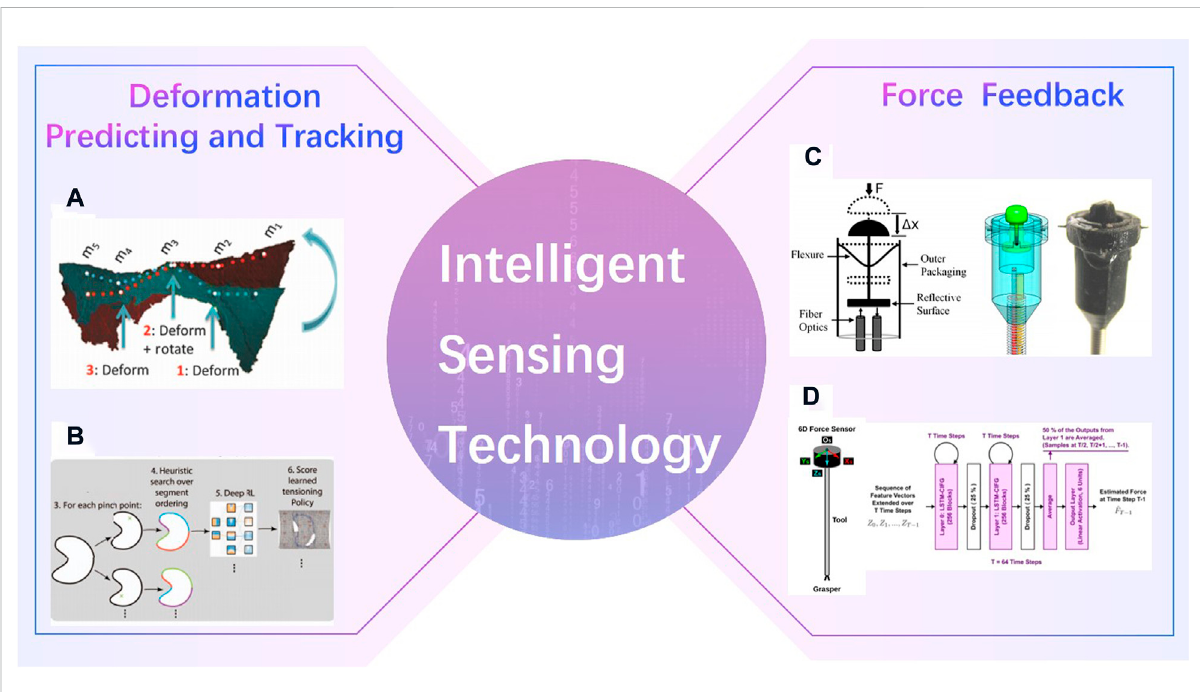
FIGURE 13 Intelligent Sensing Technology. (A) in vivo supervised autonomous soft tissue surgery (Shademan et al., 2016) (B) . Deep reinforcement learning policies were used in Pattern Cutting task (Thananjeyan et al., 2017). (C) . Force sensors in robotic surgery (Kesner and Howe, 2011) (D) . Semi- Supervised Deep Neural Network Model (Marban et al.,